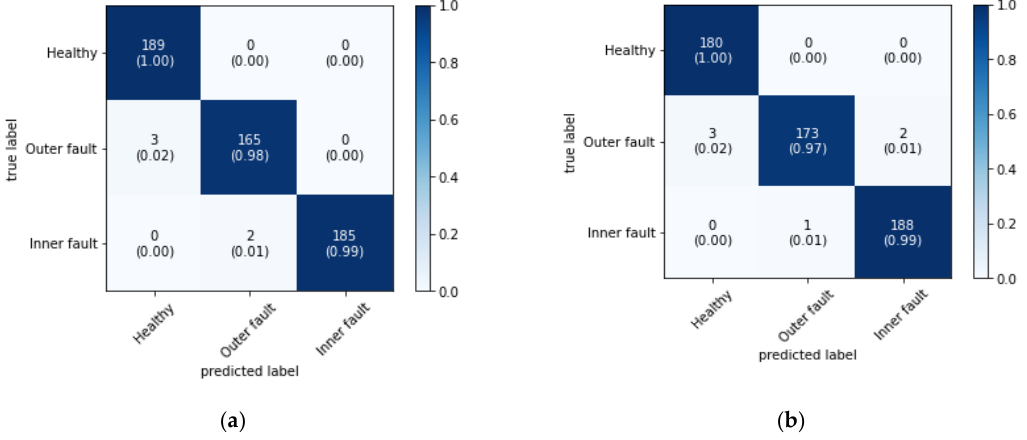
Figure 14. Confusion matrix of the sym4 wavelet for ( a ) RF and ( b ) XGBoost classifiers.